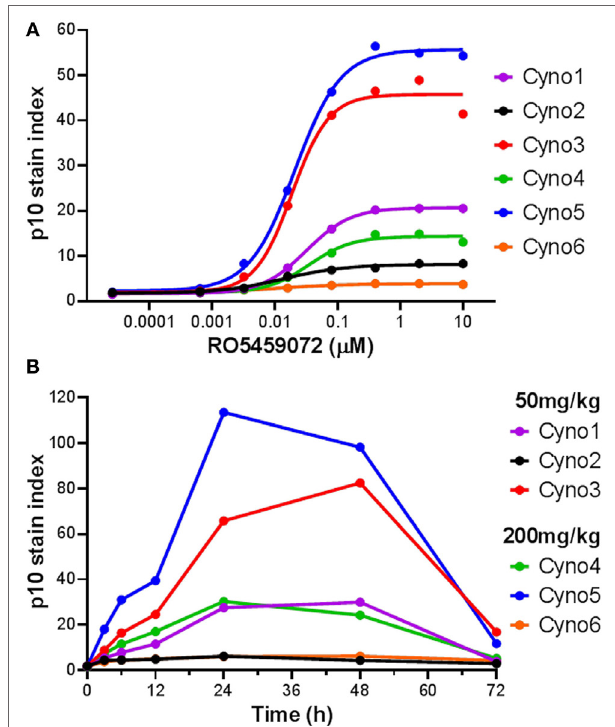
FIgURe 5 | Detection of Lip10 accumulation by flow cytometry in cynomolgus monkeys after oral administration of RO5459072. (A) Lip10 accumulation in B cells of six cynomolgus monkeys at baseline, after in vitro incubation of PBMC with a serial titration of cathepsin S inhibitor RO5459072. Curve fit was determined by non-linear regression using a variable slope model with GraphPad Prism software. (B) Detection of Lip10 accumulation in circulating B cells from six cynomolgus monkeys, measured by flow cytometry in PBMC enriched from whole blood samples taken